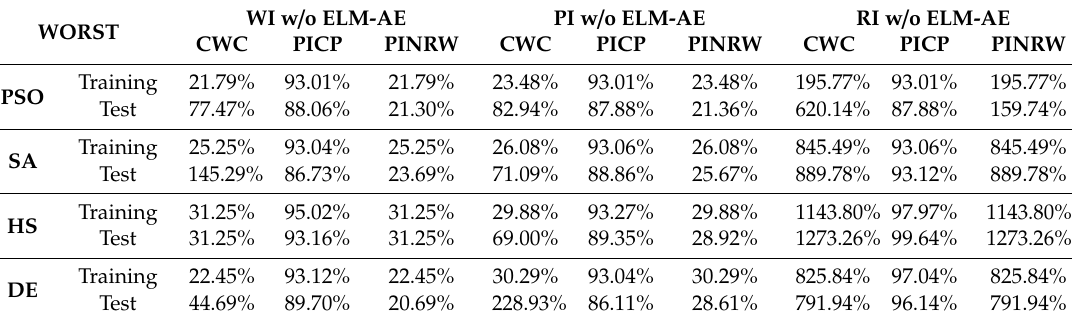
Table 5. Comparison of the worst results of di ff erent cases without